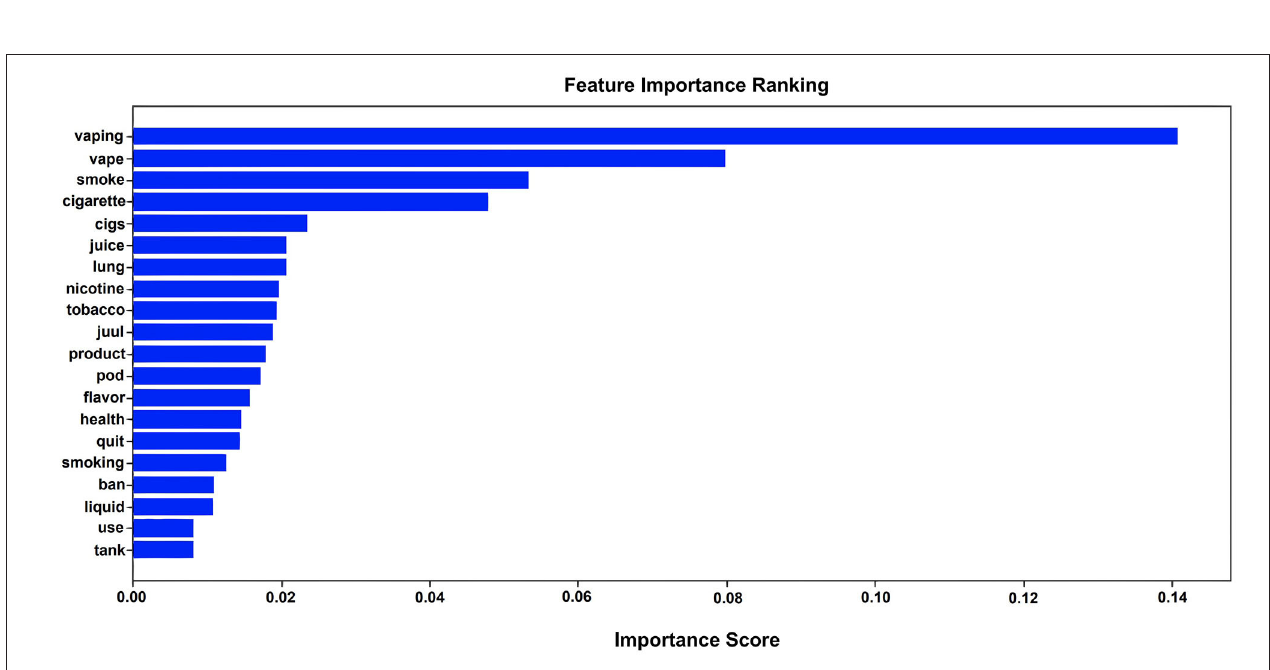
FIGURE 4 | Top 20 important features based on random forest